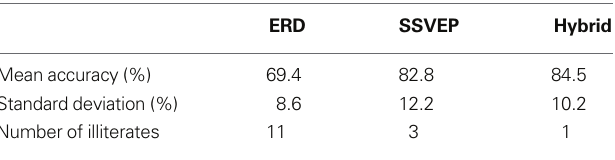
Table 1 | Mean and standard deviation of the classifi cation accuracy of 14 subjects in each condition.